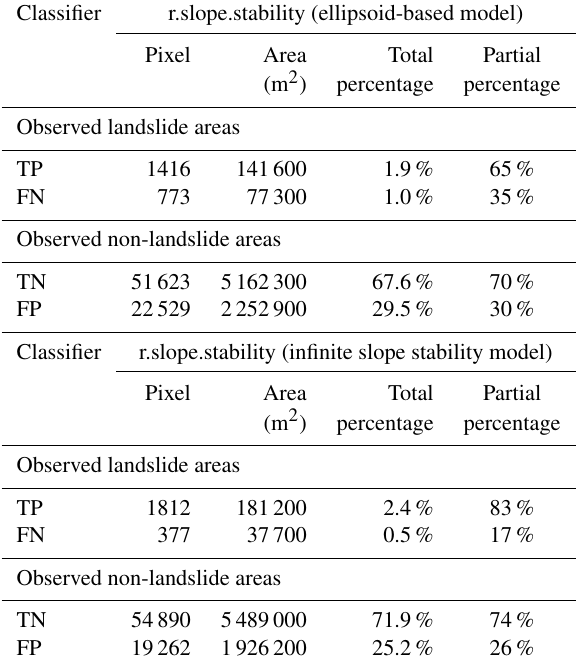
Table 2. The confusion matrix for the deterministic analysis. TP: true positive, FN: false negative, TN: true negative FP: false posi- tive.